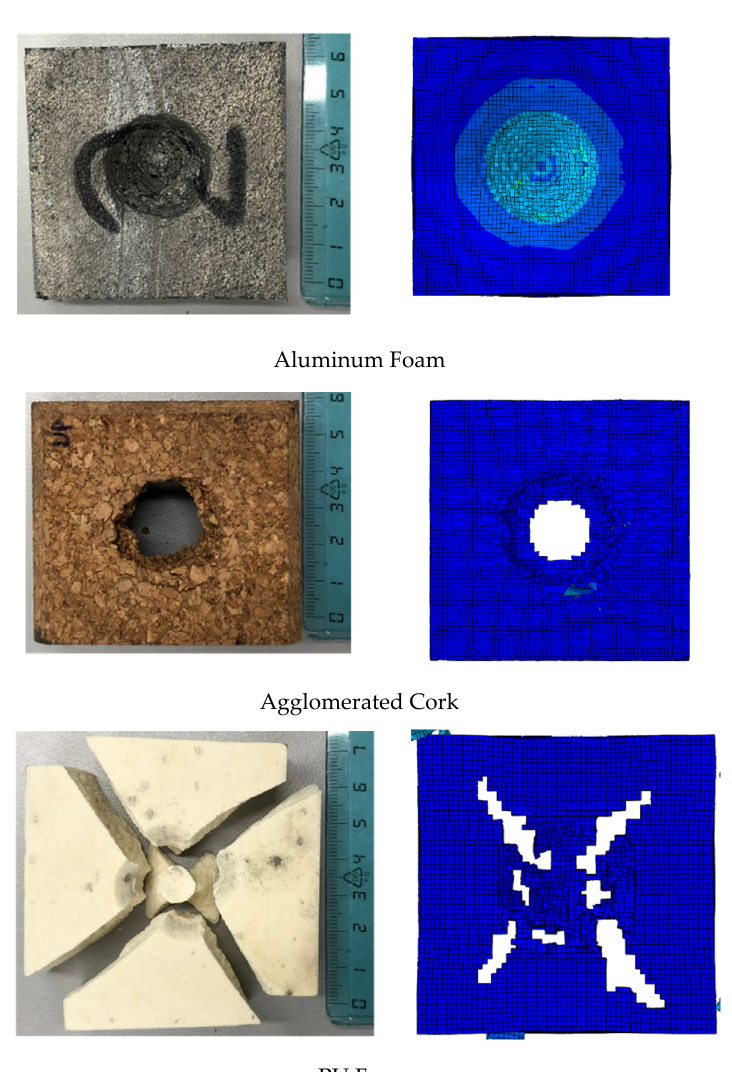
Figure 6. Experimental and FE load-displacement curves from the impact tests.